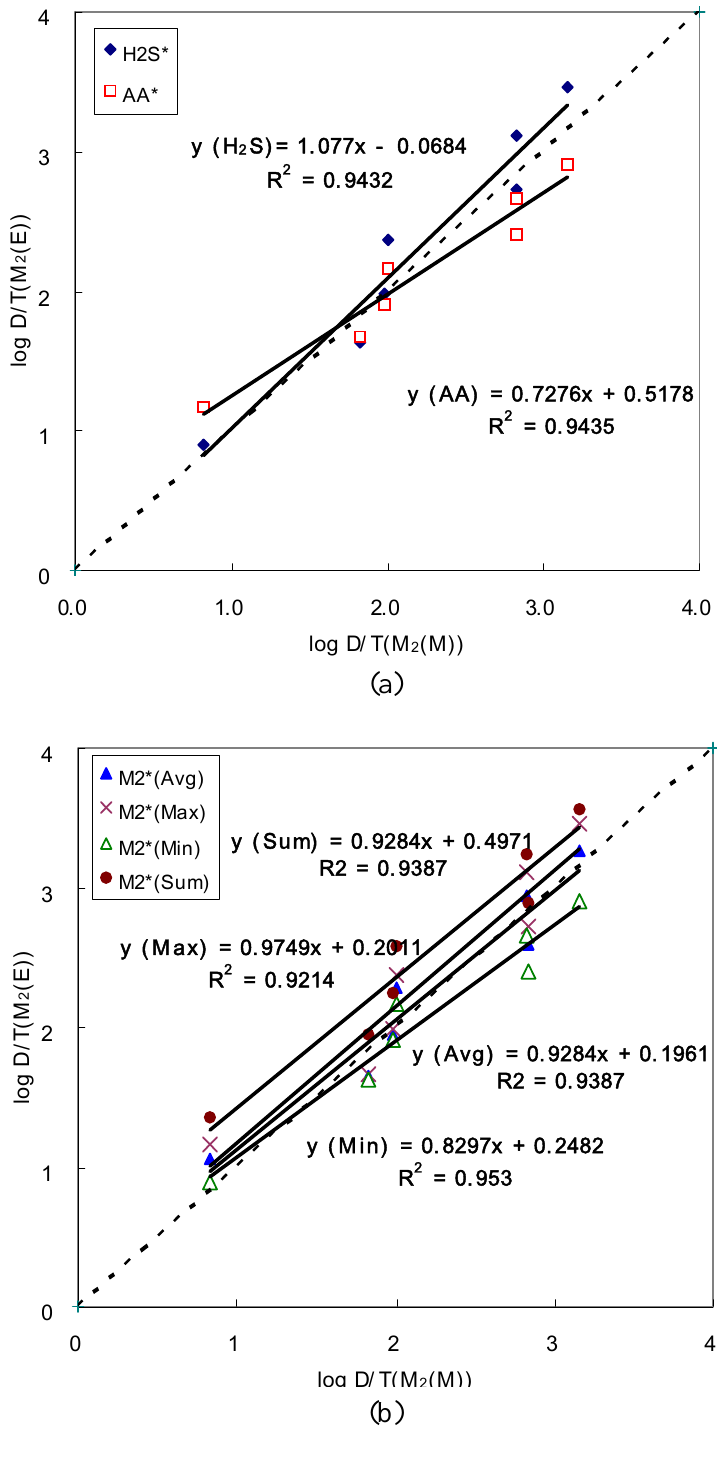
Figure 3. Comparison of the D/T ratios for M estimated values with various combinations (D/T(M (b) artificial combinations. Letters of M and E in the parenthesis denote measured and estimated,